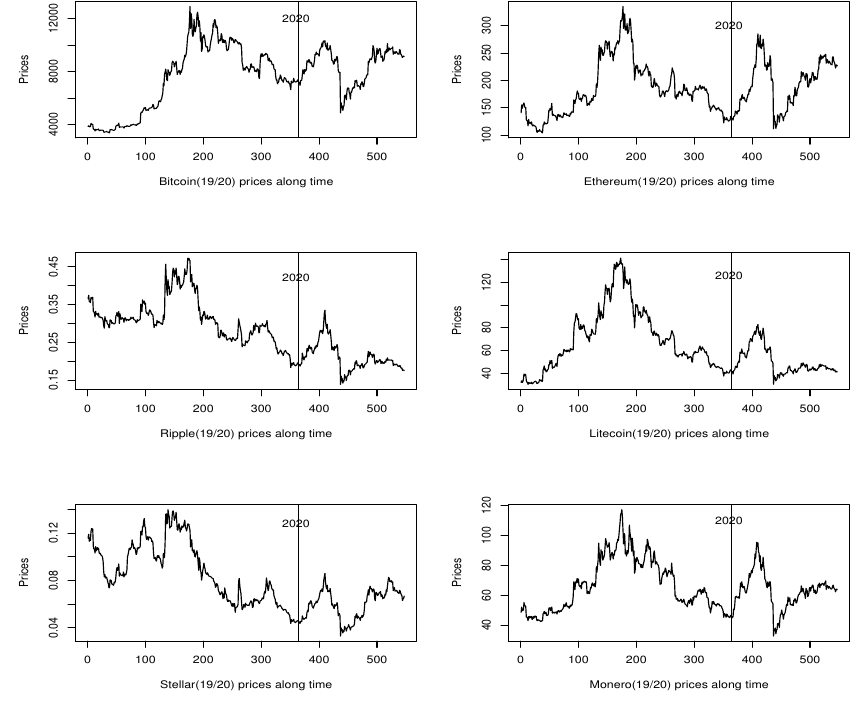
Figure 6. Price trajectories for the 2019 and 2020